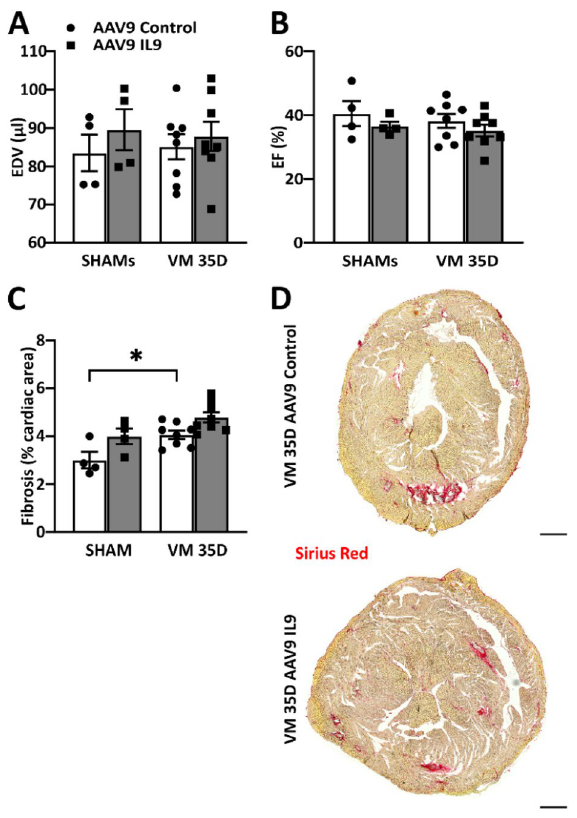
Figure 8. IL9 overexpression is not sufficient to improve cardiac function in the chronic phase during VM. ( A ) End-diastolic volume (EDV) and ( B ) ejection fraction (EF) measured by echocardiography in infected IL9- overexpressing C3H mice and infected controls 35 days after CVB3 infection. Significance assessed by two-way ANOVA, followed by Tukey’s test. ( C , D ) Fibrosis detected by Sirius Red staining in infected IL9-overexpressing hearts and controls 35 days after CVB3 infection. Scale bar = 500 µm. Significance assessed by two-way ANOVA, followed by Tukey’s test with *p ≤ 0.05. All values are expressed as mean ±